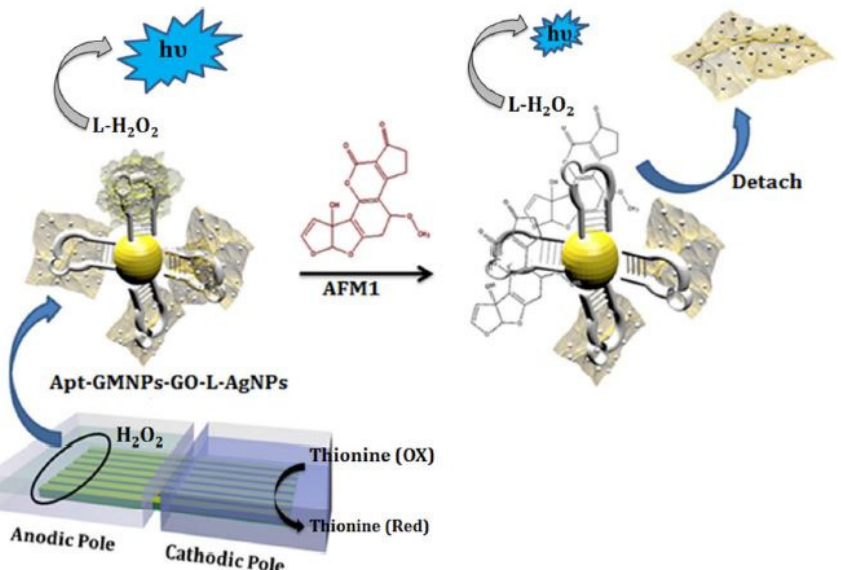
Figure 5. Representation of the immobilization process of the ATM1-based antibody with the luminol-functionalized Ag NP decorated GO [116]. Reproduced from Khoshfetrat, S.M., Bagheri, H. and Mehrgardi, M.A., 2018. Visual electrochemiluminescence biosensing of aflatoxin M1 based on luminol-functionalized, silver nanoparticle-decorated graphene oxide. Biosensors and Bioelectronics , 100 , pp. 382–388.